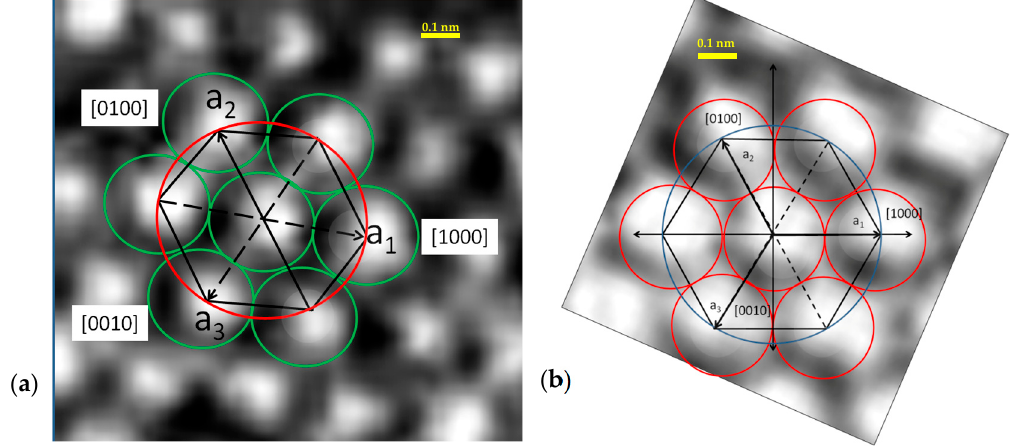
Figure 9. Elementary cells in the tension region ( a ) and compression region ( b ) of Figures 5c and 6a.